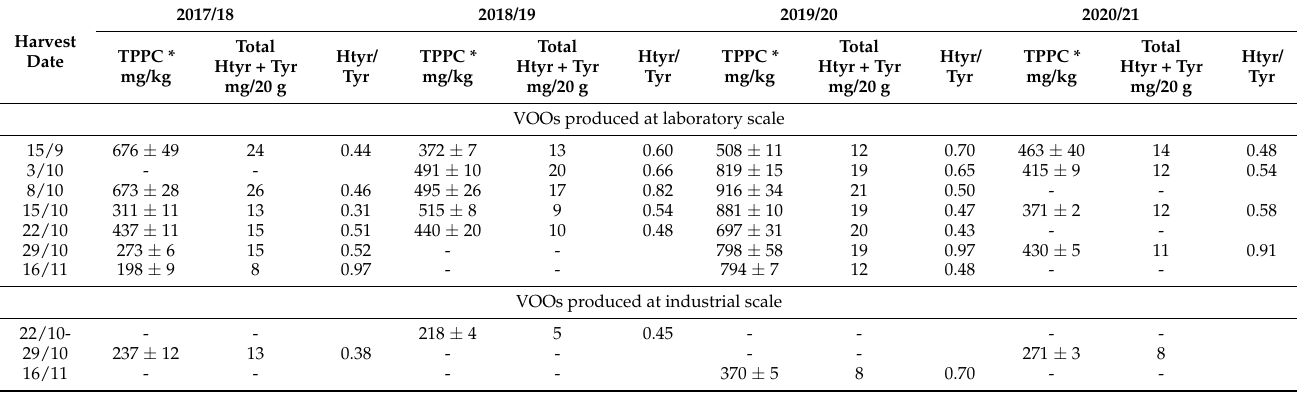
Table 7. Variability in the total polar phenol (TPP), total hydroxytyrosol (Htyr) and tyrosol (Tyr) content, and ratio Htyr to Tyr of VOOs extracted from olives cv. Chondrolia Chalkidikis and Chalkidiki at different stages of maturity for